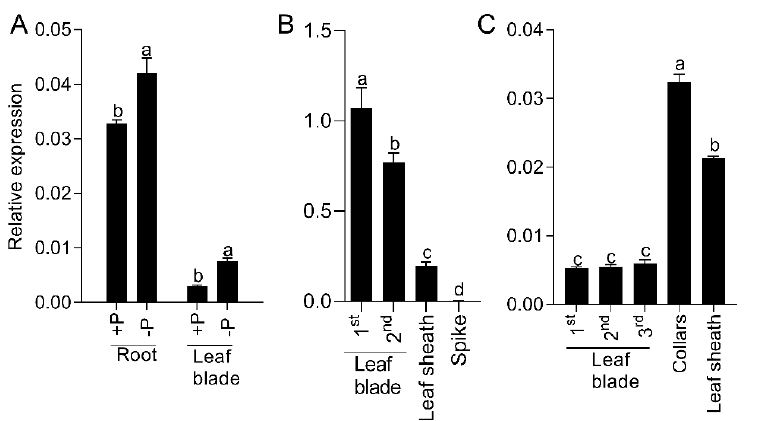
Figure 1. Relative transcript levels of OsPHT1;4 in rice cv. WYJ 7. The seedlings (3 days old) were grown hydroponically ( A ) and in pot soil ( B , C ) for 13 and 20 weeks. Different tissues were harvested and qRT-PCR analysis was carried out to determine the relative transcript levels of OsPHT1;4 . OsActin1 was used as an internal control. Values are means ± SE ( n = 3). Different letters above the bars indicate significant differences ( p < 0.05, one-way ANOVA).